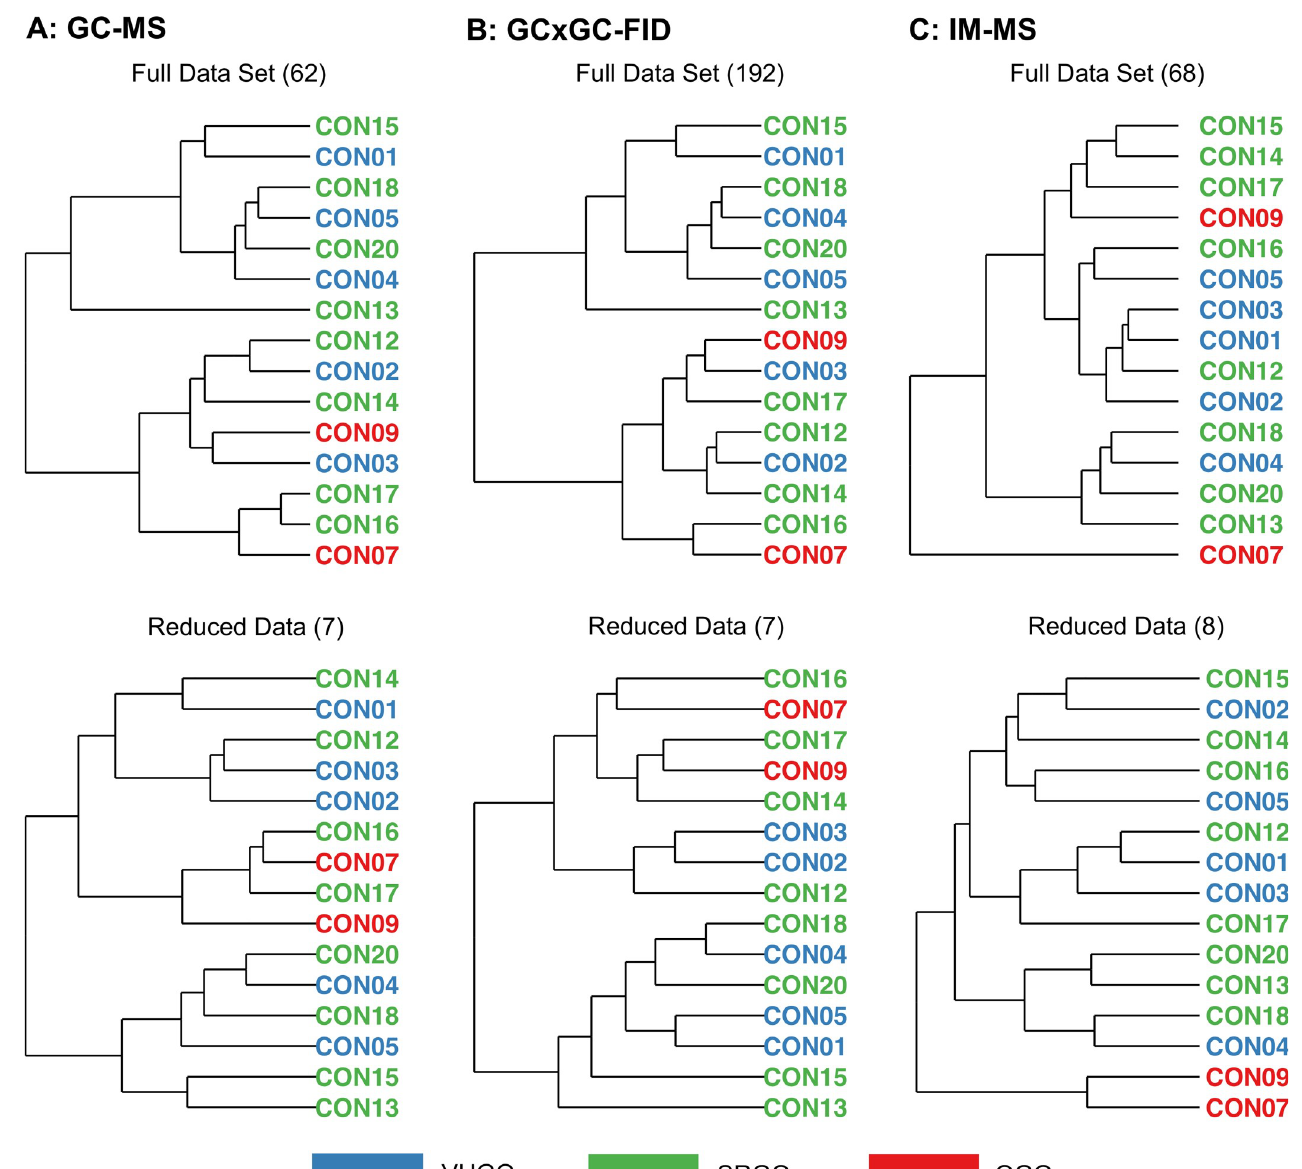
Fig 10. Dendrograms for Petroleum UVCB samples clustering from the reduced data set analyzed using 3 different techniques.